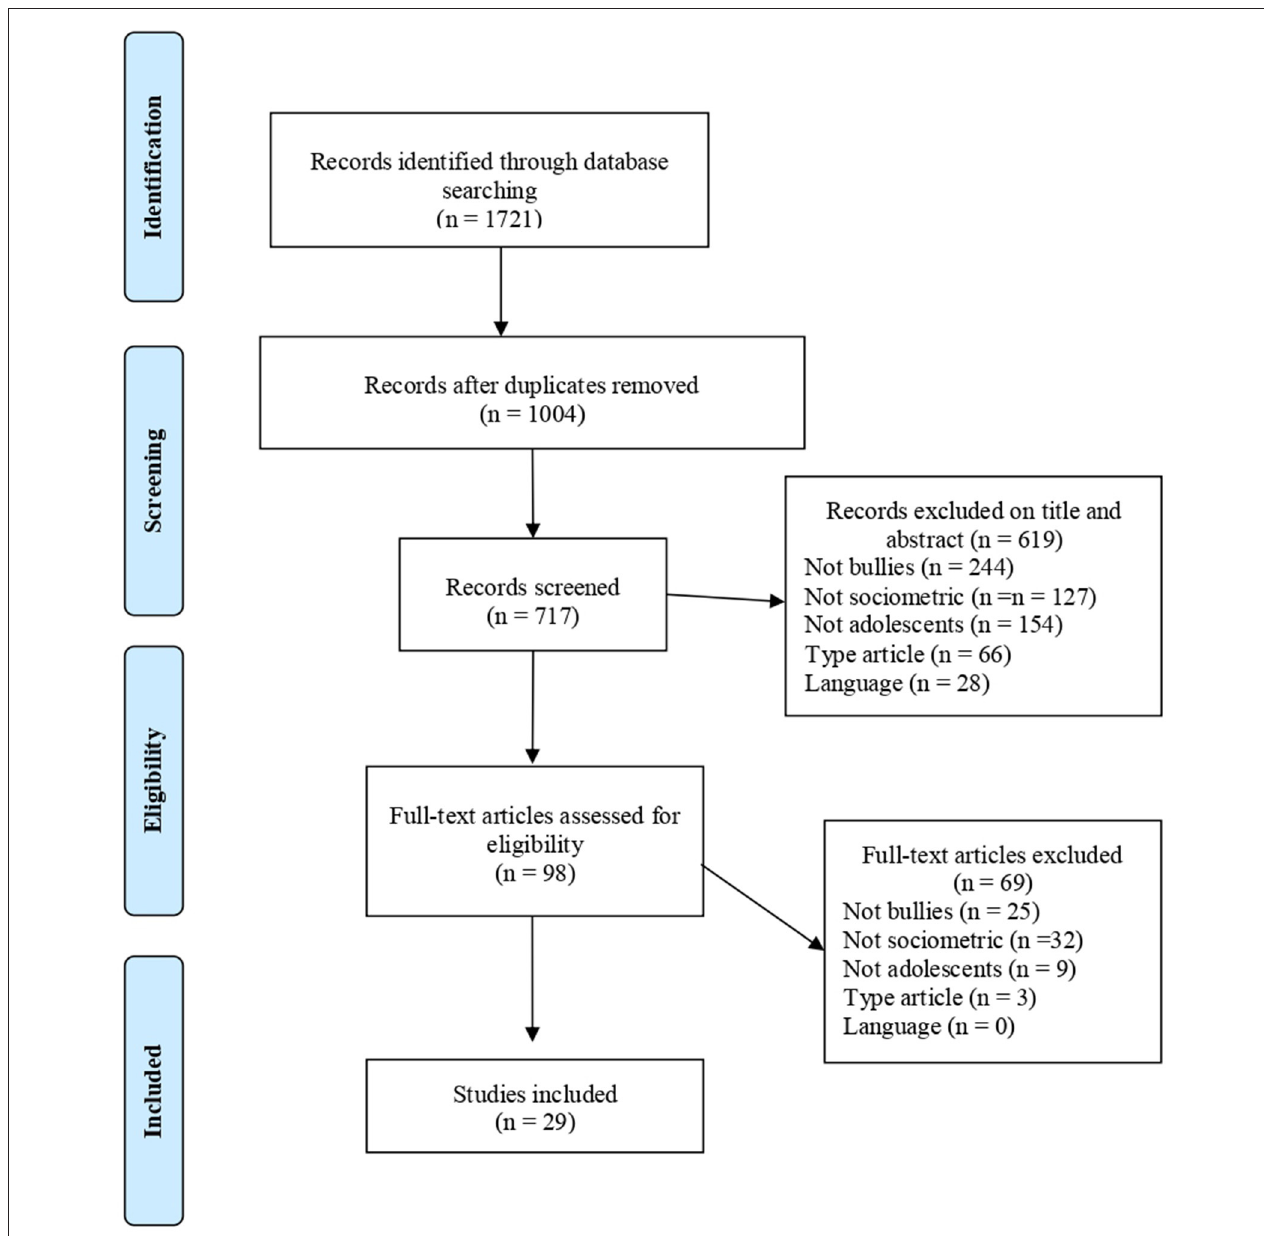
FIGURE 1 | PRISMA flow of information through the different phases of a systematic review. Exclusion criteria: Not bullies: studies not investigating bully role nor bullying in school; Not sociometric: studies not investigating social status through sociometric measures; Not adolescents: studies not involving adolescent pa1ticipants; Type article: non-quantitative studies or scientific articles; Language: study not written in English or